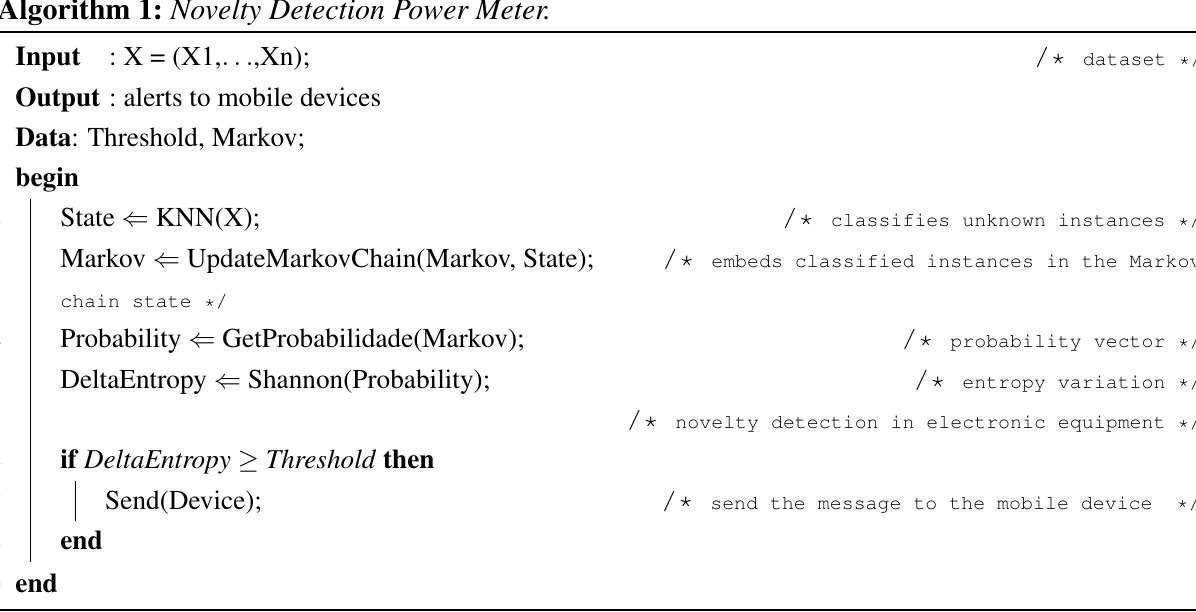
Algorithm 1: Novelty Detection Power